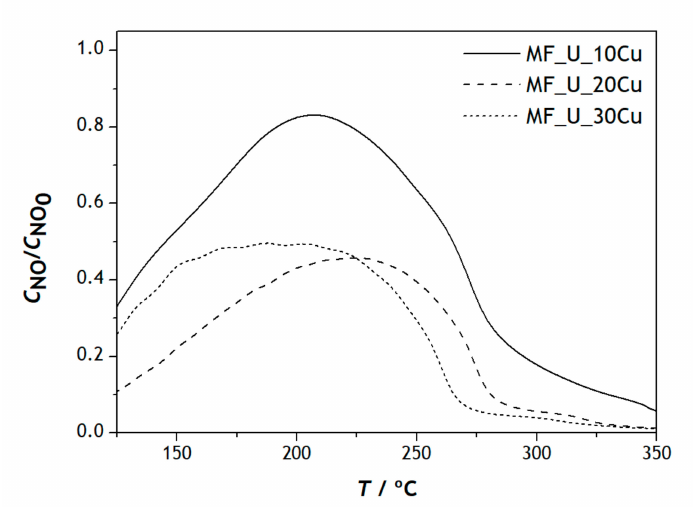
Figure 7. NO concentration in the presence of samples with 10, 20 and 30% Cu with [NO] = 1000 ppm in He with 5% of O 2 .